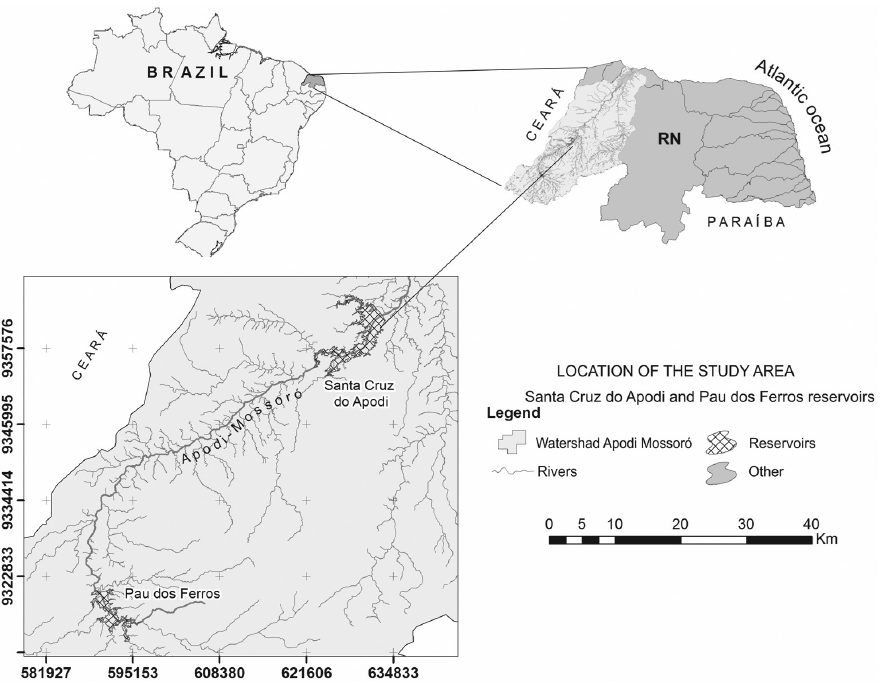
Figure 1. Study area location of the and collection points in the Santa Cruz do Apodi and Pau dos Ferros reservoirs in Rio Grande do Norte state, brazilian